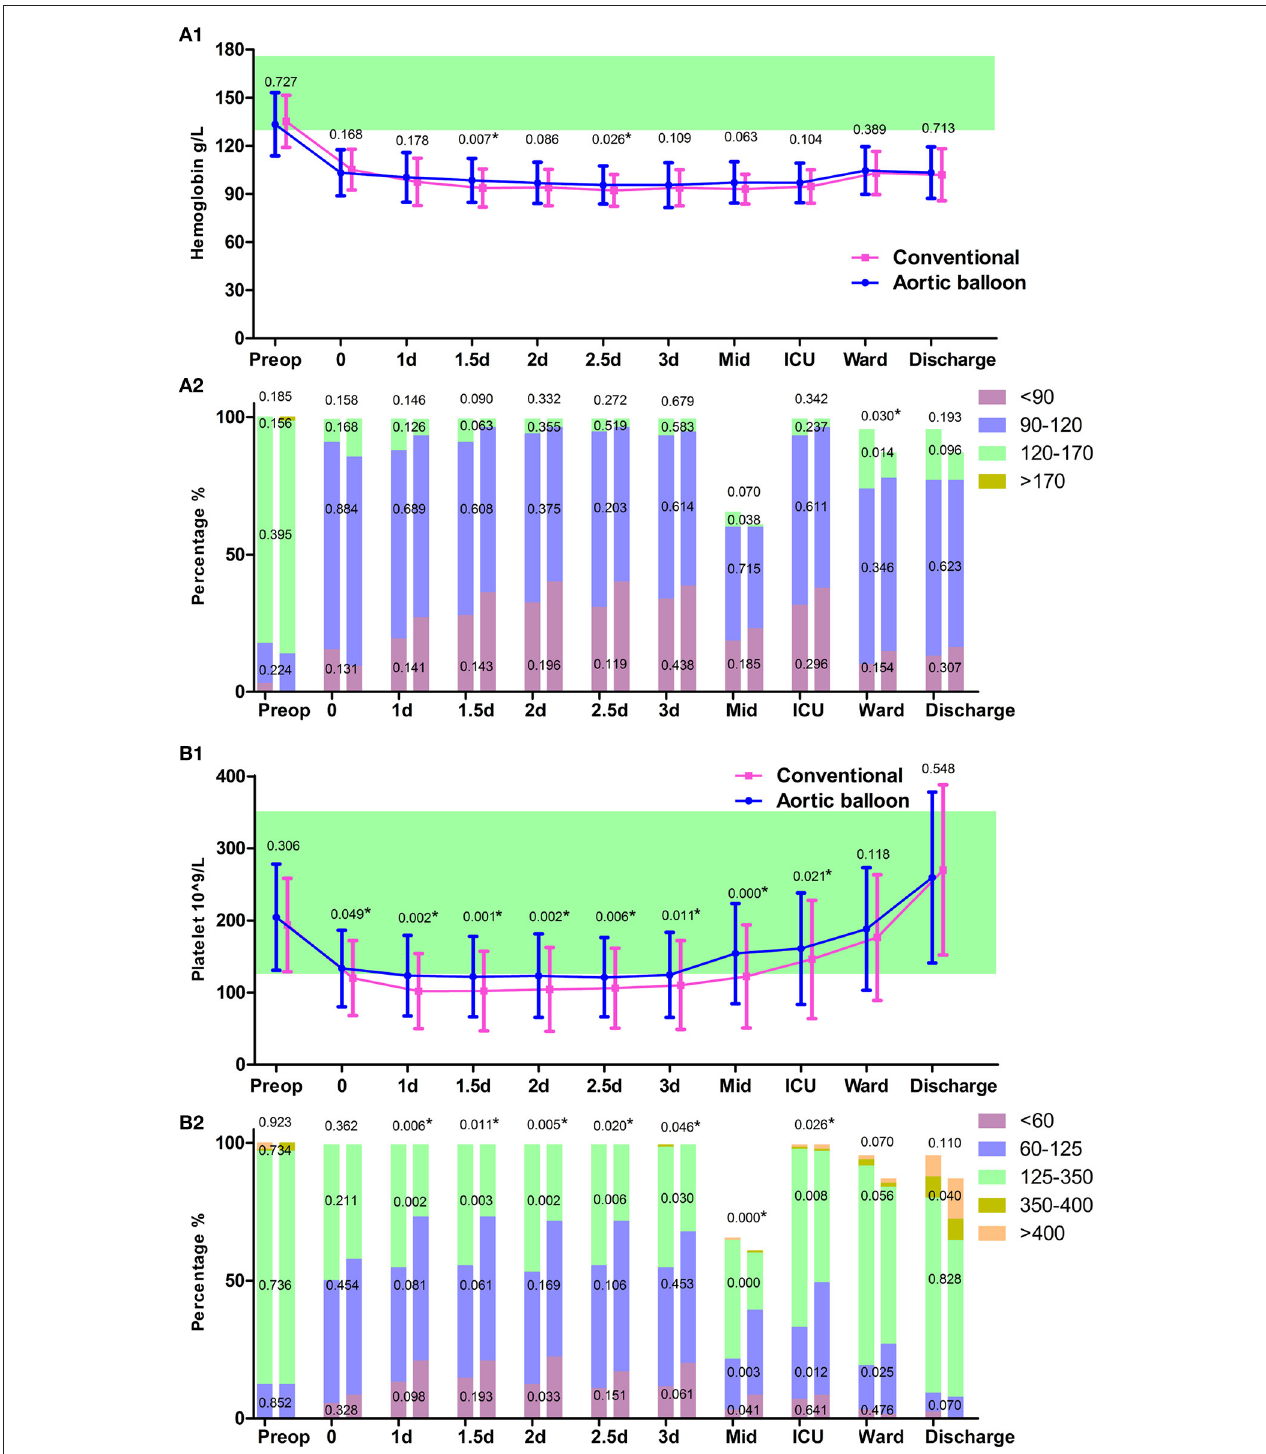
FIGURE 3 | Blood routine test. (A1) The trajectory of hemoglobin. (A1) hemoglobin grading in the column. (B1) The trajectory of platelet count. (B2) Platelet count grading in the column. Data points are represented by mean with standard deviation bars. * P < 0.05.